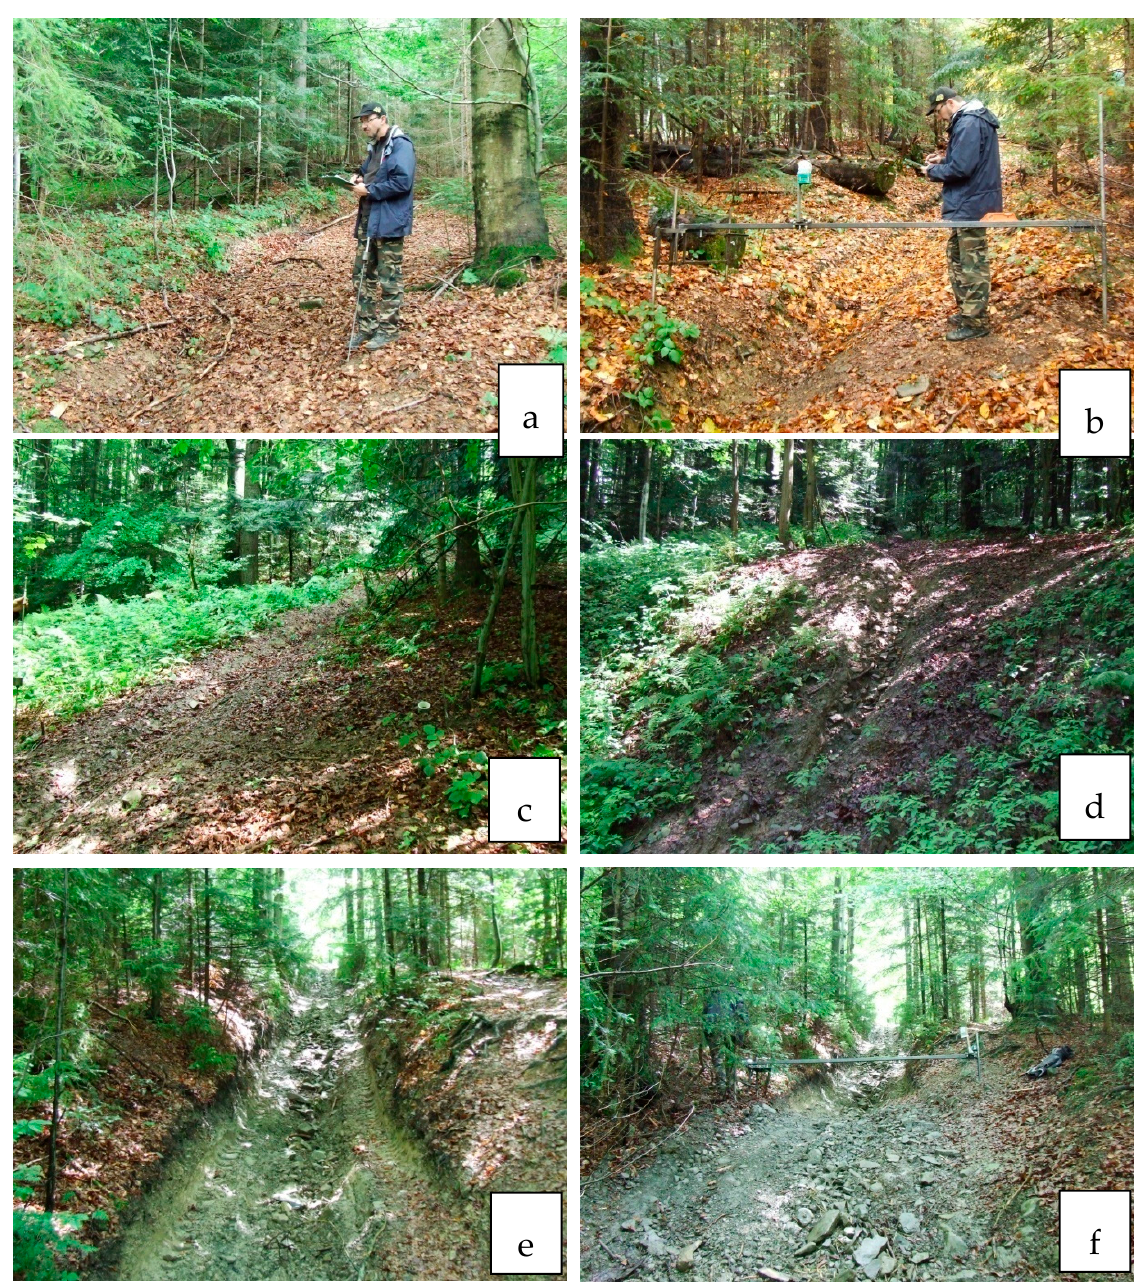
Figure 1. Photographs of the sections of skid trails selected for the study: ( a ) Ht129U, ( b ) Ht129L, ( c ) Ht130U, ( d ) Ht130L, ( e ) Tt129U, and ( f ) Tt129L.